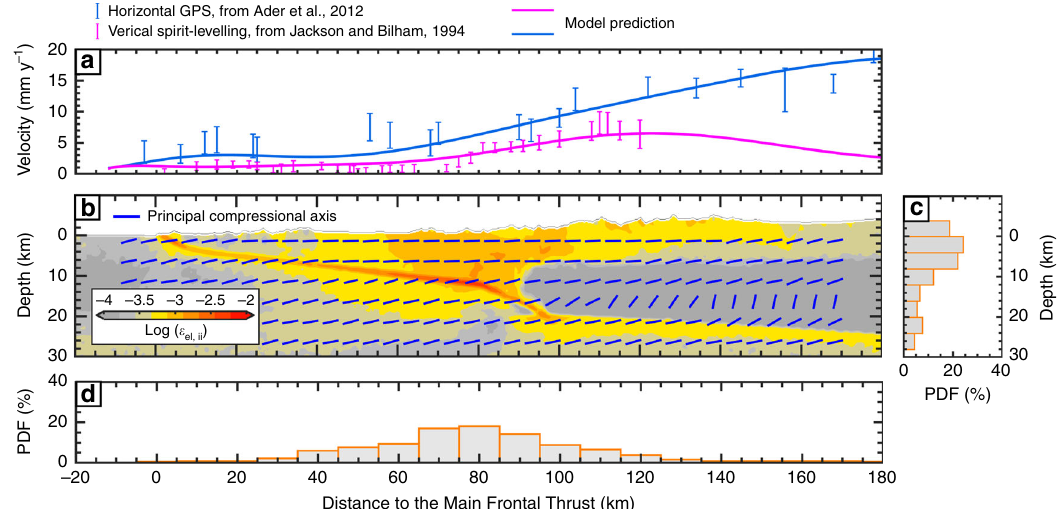
Fig. 2 Interseismic behaviour computed in the 2D model. a , Observed vs. synthetic present-day velocity fi elds. Observed fi eld (error bars) is shown in blue (horizontal GPS 8 ) and violet (spirit-levelling 35 ) bars, respectively. Solid lines show the corresponding horizontal and vertical modelling prediction. b , Elastic strain regime across the Himalaya inferred over an interseismic period of 350 years and orientation of principal compressional axes (blue bars). Histograms in c and d show the vertical and horizontal off-megathrust faulting distributions,